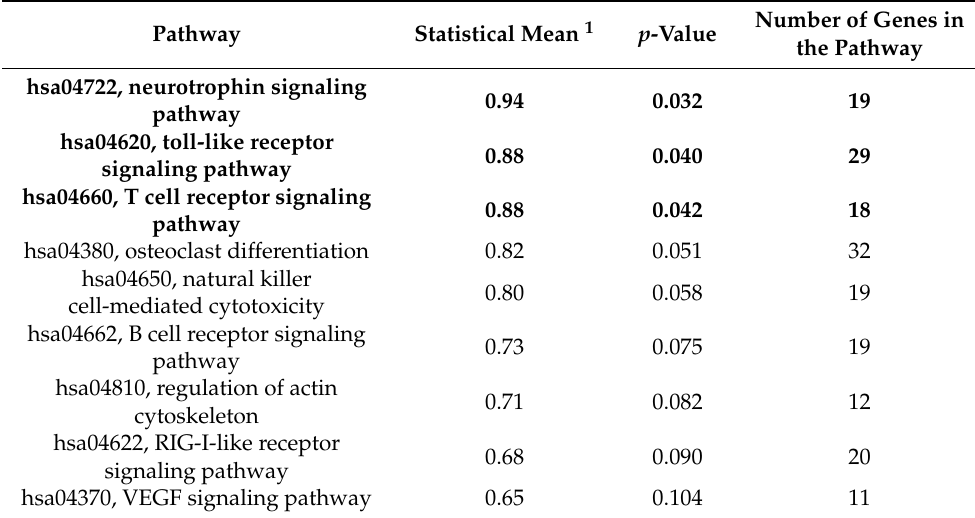
Table 5. Significantly deregulated pathways. AV3 cells incubated with enterovirus strains obtained from cases of autoimmune thyroid disorders vs. AV3 cells incubated with virus-free control super- natants. In bold are significantly deregulated pathways. Pathway Statistical Mean